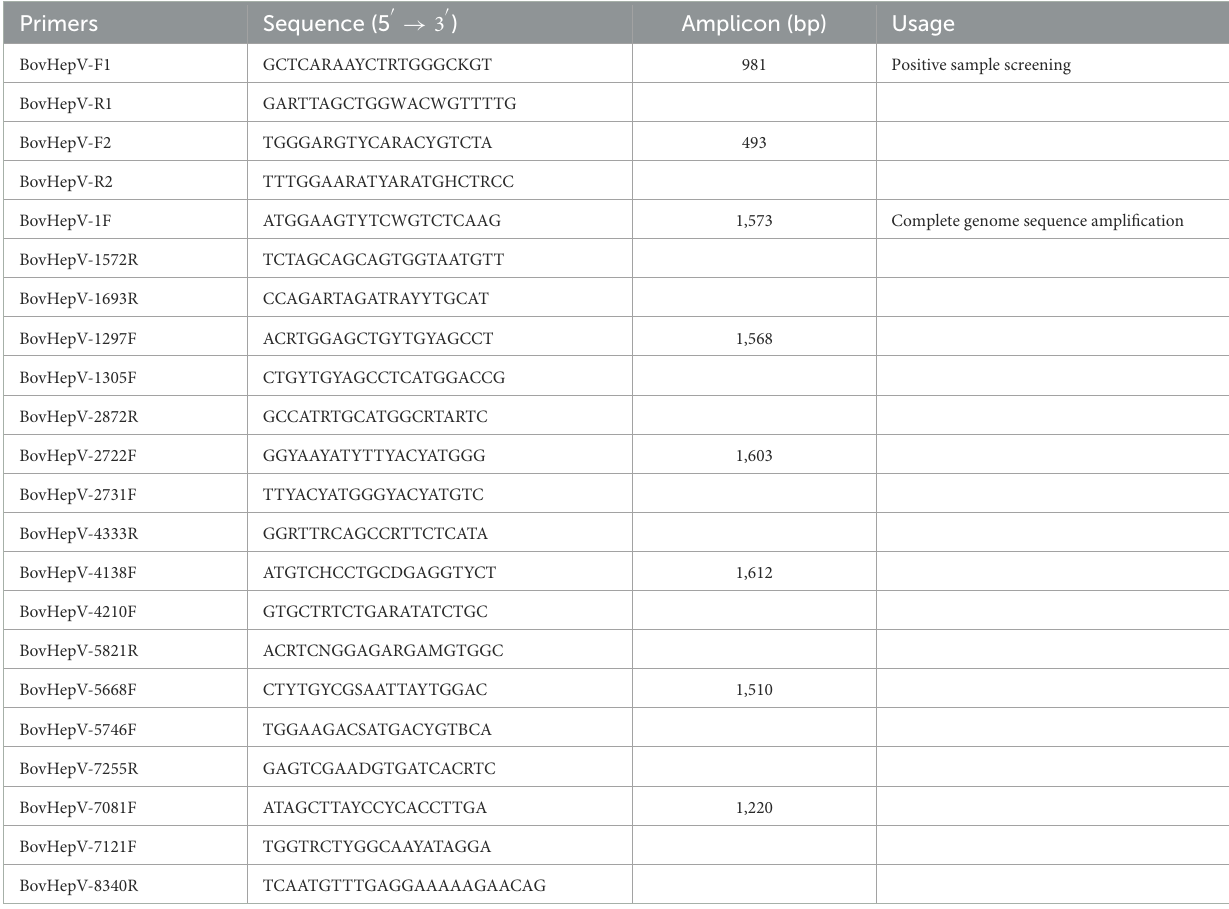
TABLE 1 Primers used in this